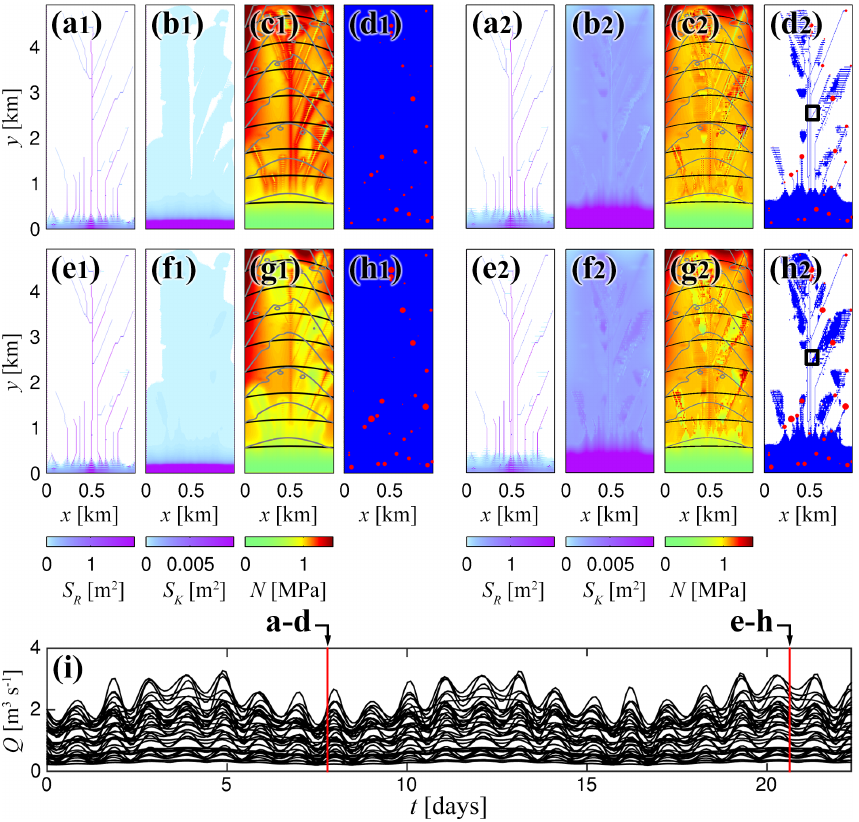
Figure 16. Snapshots of drainage system evolution for the model without a percolation cut-off (left), and with one (right). Panels (a) and (e) : S R conduit size. Panels (b) and (f) : S K conduit size. Panels (c) and (g) : effective pressure, black lines are 100m surface contours, grey lines 100m bed contours. Panels (d) and (h) : connectedness of conduits, indicated in blue if S R ,ij > S PR or S K ,ij > S PK along a given edge, in white otherwise. Red dots indicate moulin locations, size of dot scaled with instantaneous water supply. Row (a) – (d) shows solutions at t = 7 . 8 days and row (e) – (h) at t = 20 . 6 days. Panel (i) : water supply time series for all moulins in the